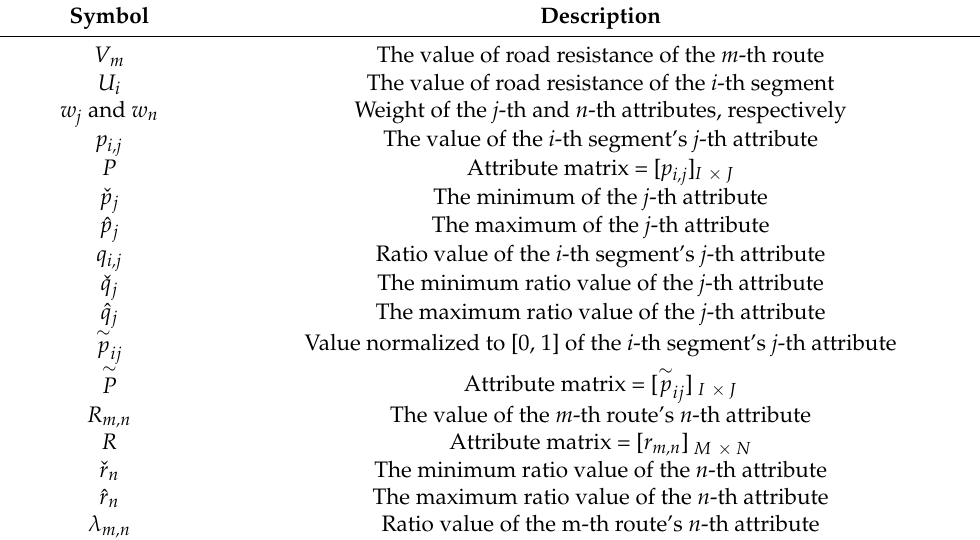
Table 1. Definition of relative